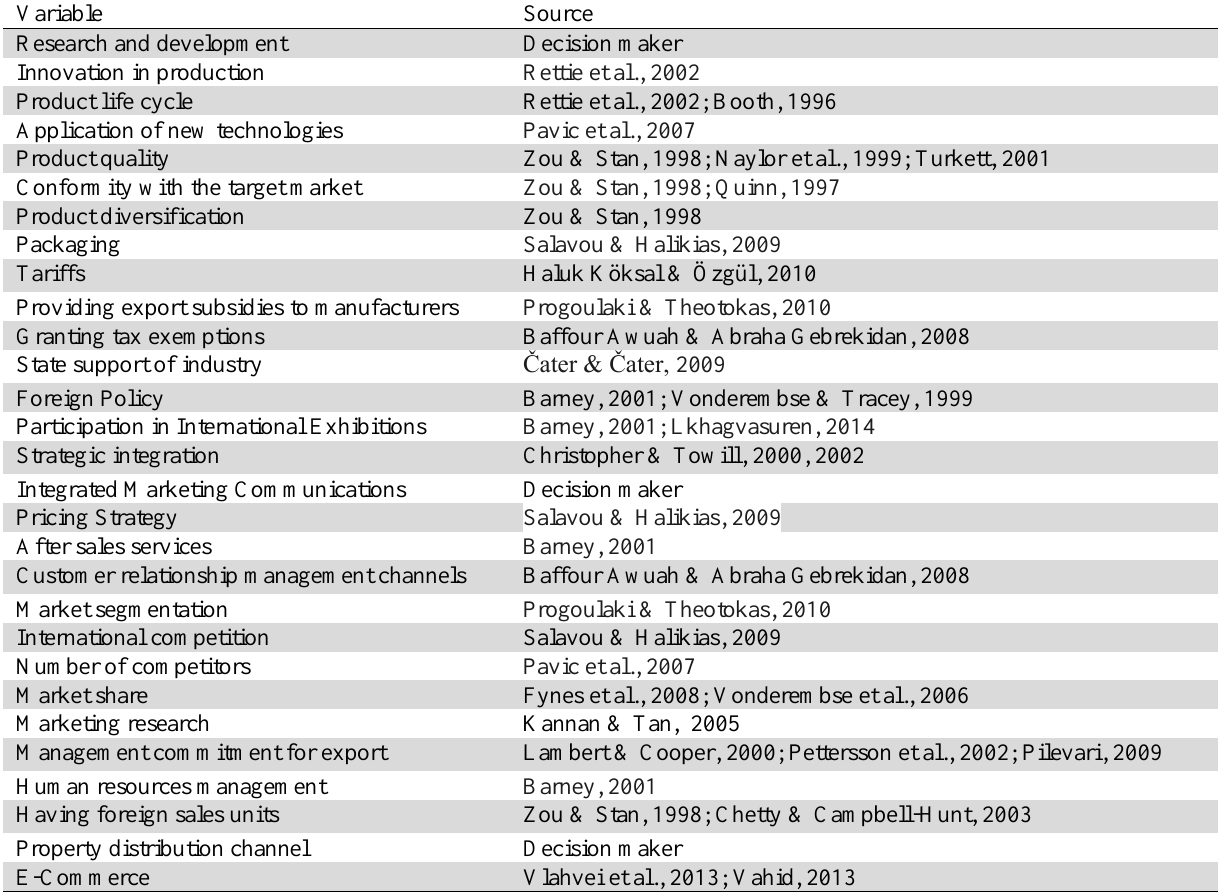
The summary of factors influencing development of supply chain effectiveness and export development